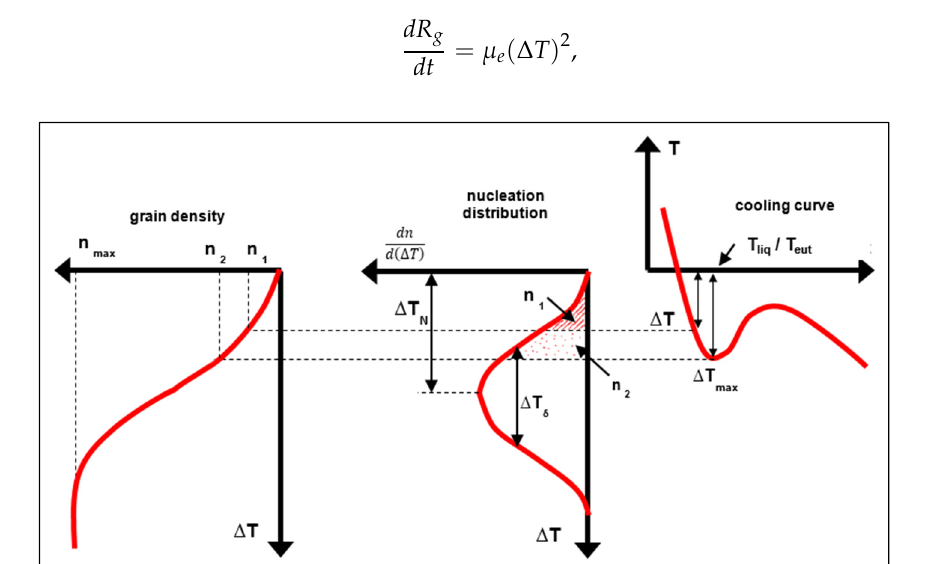
Figure 2. Undercooling definition.